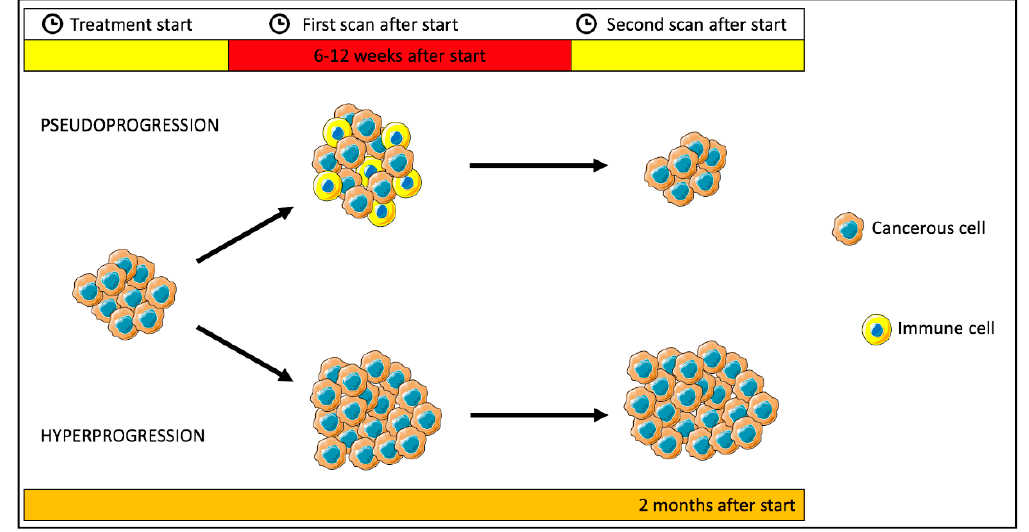
Figure 2. Illustration of two different atypical pattern of immunotherapy response: pseudoprogression/hyperprogression. Pseudoprogression consists of transient enlargement of lesion in the first timepoint post-ICI evaluation, mostly due to immune cells infiltration and is associated with a favorable outcome. Hyperprogression describes an increase in tumor volume growth rate during immunotherapy, assessed at the first timepoint post-therapy evaluation, and confirmed within 2 months after the start of therapy.